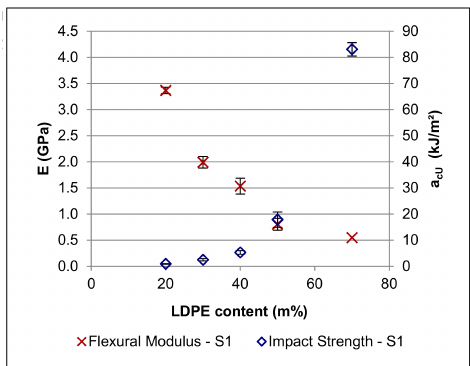
Figure 4. Modulus ( E ) and Charpy impact strength ( a cU ) of the formulations of Series